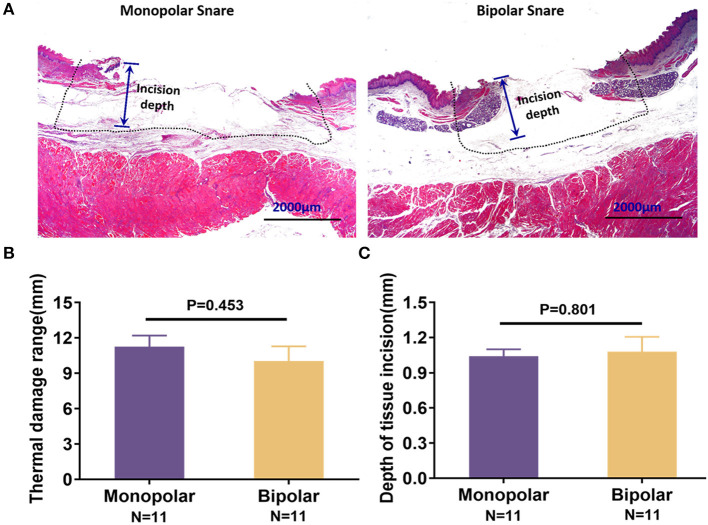
Acute injury of the digestive tract produced by the monopolar snare and bipolar snare during operation. (A) H&E staining of porcine esophagus mucosa removed with the two snares. The thermal damage range was indicted by dotted line. Scale bars: 2,000 μm. These pictures were captured by camera of a microscope. Comparison of thermal damage range (B) and incision depth (C) between the two snare groups. Thermal damage range and incision depth were calculated by software ImageJ. Data presented as means ± SD (N = total quantity of resection). Student t test was taken to do statistical analysis.